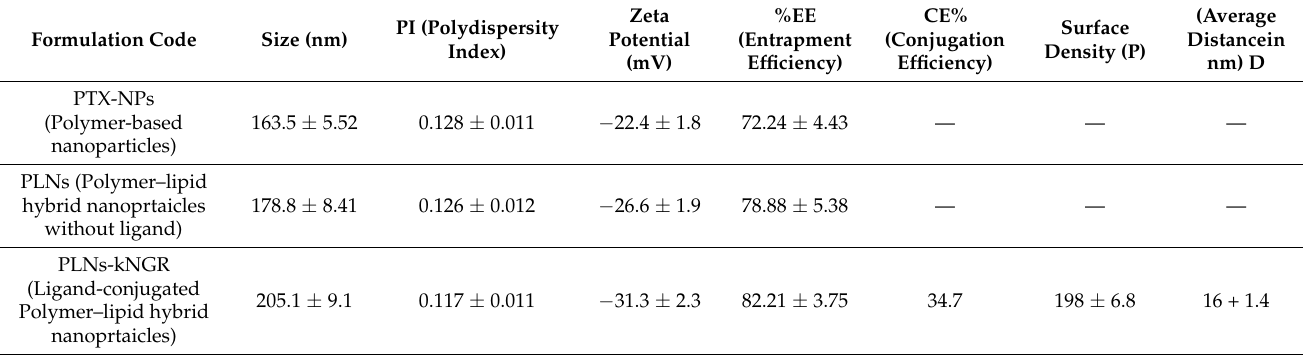
Figure 3. ( A ) Structure of polymer–lipid hybrid nanoparticles with schematic comparison of ( a ) kNGR-conjugated polymer–lipid hybrid nanoparticles ( b ) unconjugated polymer–lipid hybrid nanoparticles ( B ) SEM photograph of PLNs-kNGR. Table 1. Physicochemical characteristics of various PTX-loaded